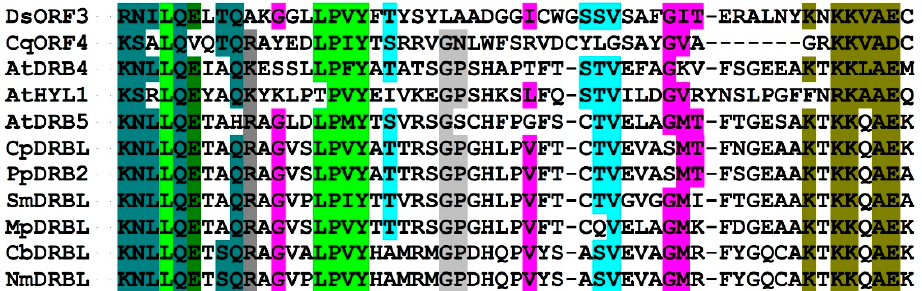
Figure 4. Multiple sequence alignment of the dsRNA-binding active centers of proteins HYL1, DRB4 and DRB5 from A. thaliana with vDRB proteins of D. scoparium (DsORF3) and C. quitensis (CqORF4) as well as DRB-like proteins of moss Ceratodon purpureus (CpDRBL—accession KAG0625911), moss Physcomitrium patens (PpDRB2-XP_024393530), lycophyte Selaginella moellendorffii (SmDRBL-EFJ14280), liverwort Marchantia polymorpha (MpDRBL-PTQ26790), charophyte algae Chara braunii (CbDRBL-GGXX01036972), charophyte algae Nitella mirabilis (NmDRBL-JV799478), charophyte algae Spirogyra pratensis (SpDRBL-GFWN01008525). Motifs characteristic of domains of DSRM_AtDRB-like family are shown in color.